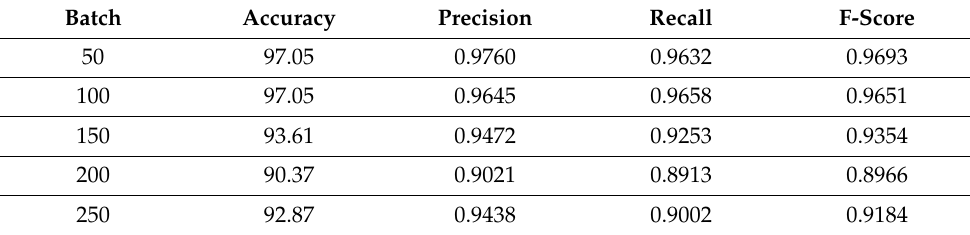
Table 4. For 500 epochs and 10-fold cross-validation, the metrics were calculated by increasing the batch size from 50 to